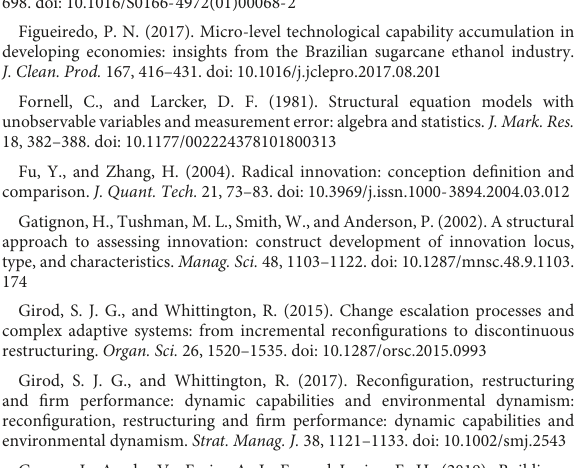
Figueiredo, P. N. (2002). Learning processes features and technological capability-accumulation: explaining inter-firm differences. Technovation 22, 685– 698. doi: 10.1016/S0166-4972(01)00068-2 Figueiredo, P. N. (2017). Micro-level technological capability accumulation in developing economies: insights from the Brazilian sugarcane ethanol